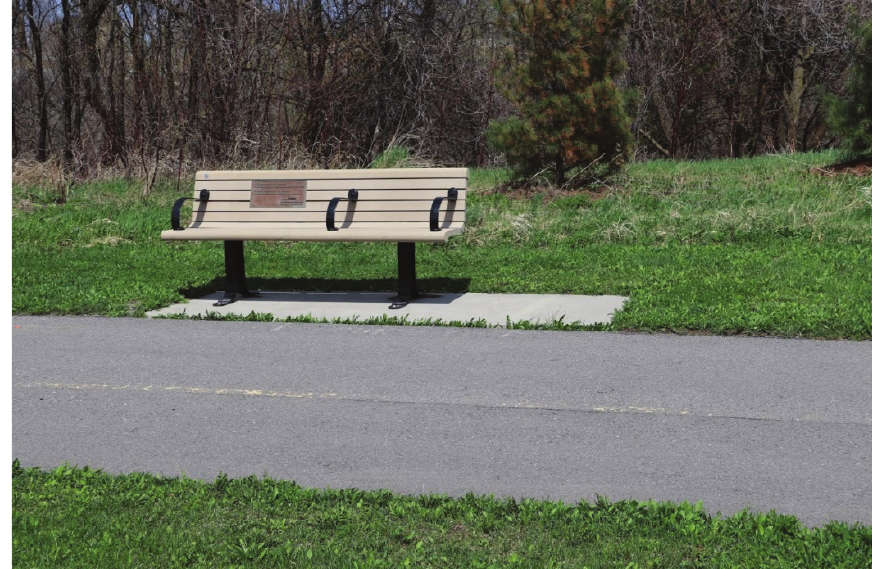
Figure A2. Bench installation in Ottawa. Canadian bench, similar to those presented in WHO Global Database of Age- friendly Practices